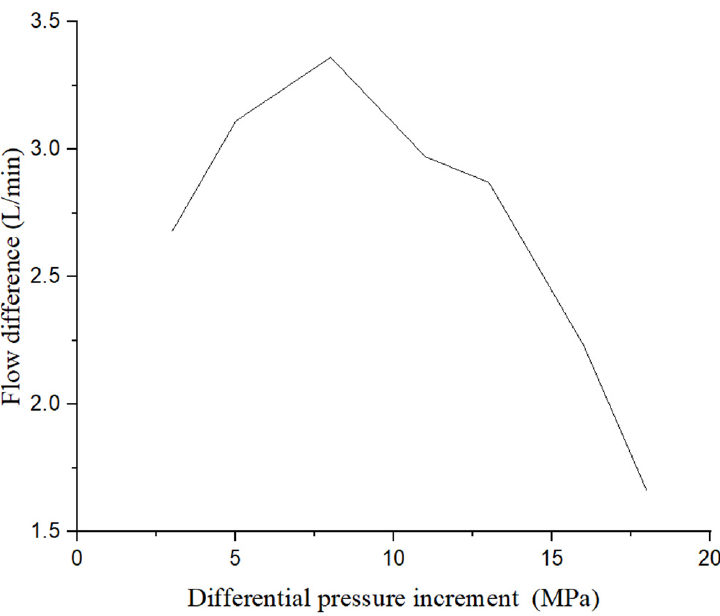
Figure 7. Influence of differential pressure increment on flow rate. Table 2. Corresponding relationship between flow-rate difference and differential pressure incre- ment.